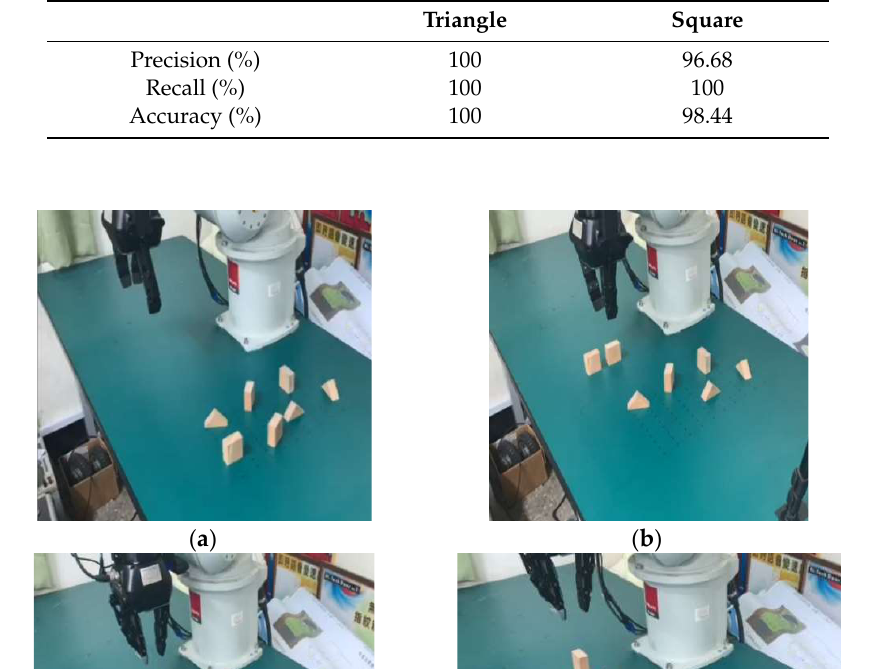
Table 4. Performance of R-CNN to recognize triangle and square block.